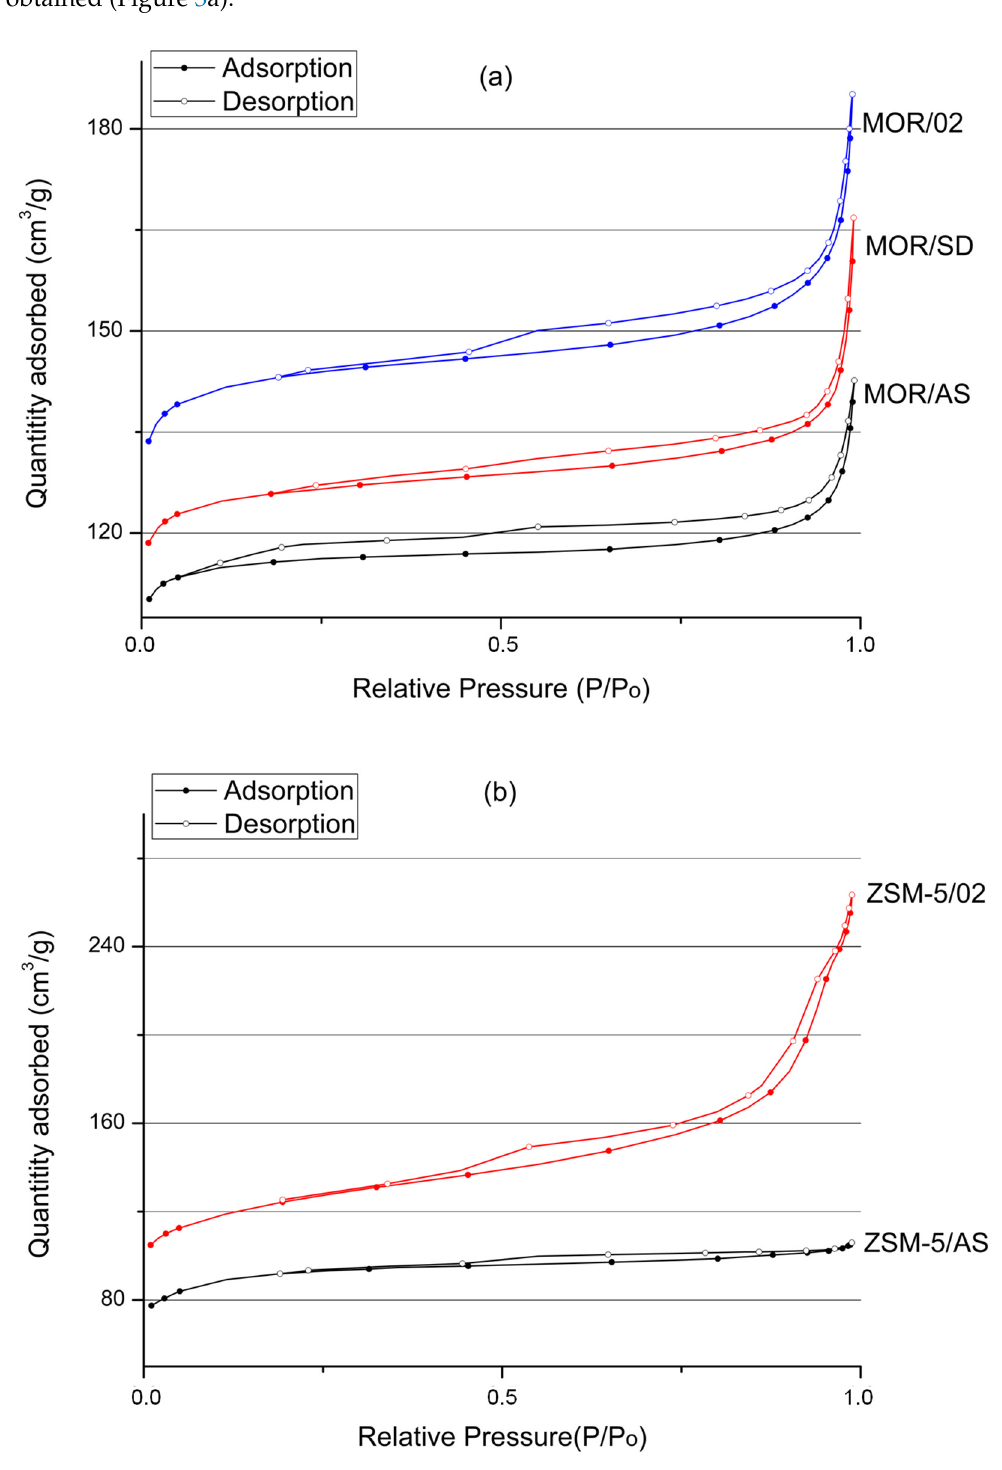
Figure 3. N 2 adsorption–desorption curves for ( a ) Mordenites: MOR/02/ MOR/SD, and MOR/AS. ( b ) ZSM-5: ZSM-4/02 and ZSM-5/AS.